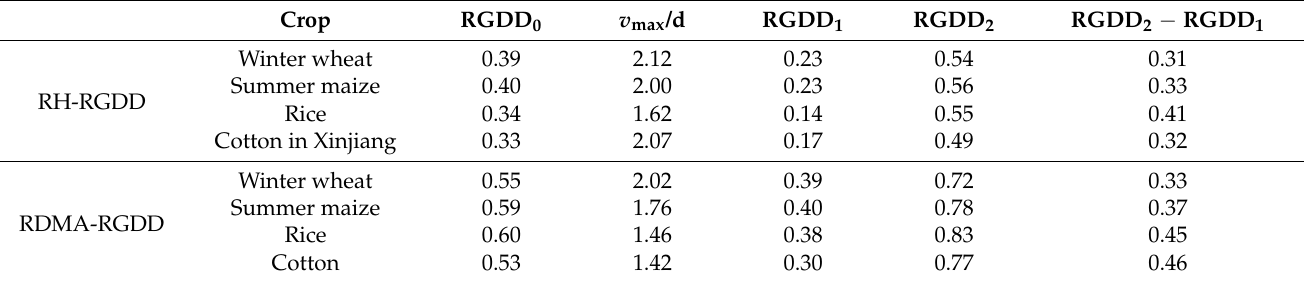
increase in RH or RDMA.